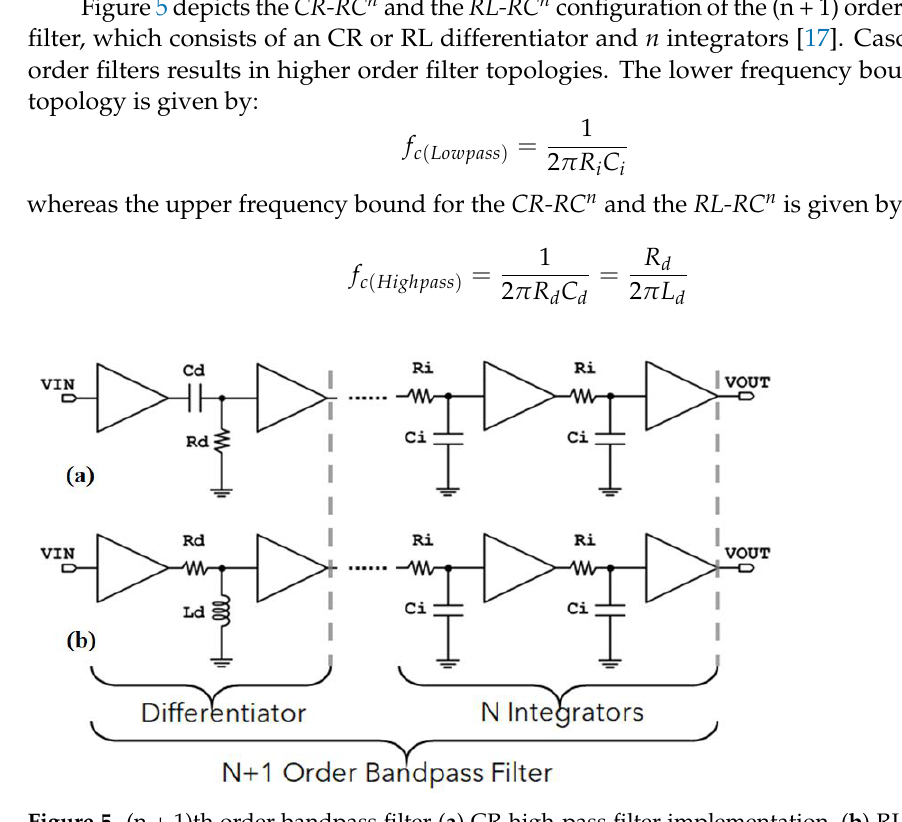
Table 1. Field mill sensor parameters.